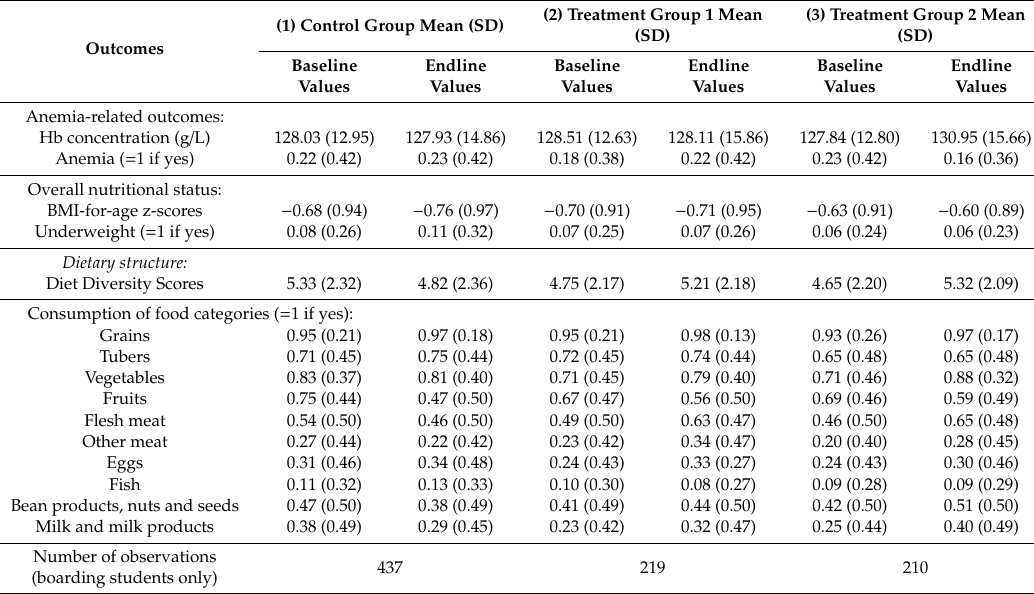
Table 2. Summary statistics of variables measured before and after the